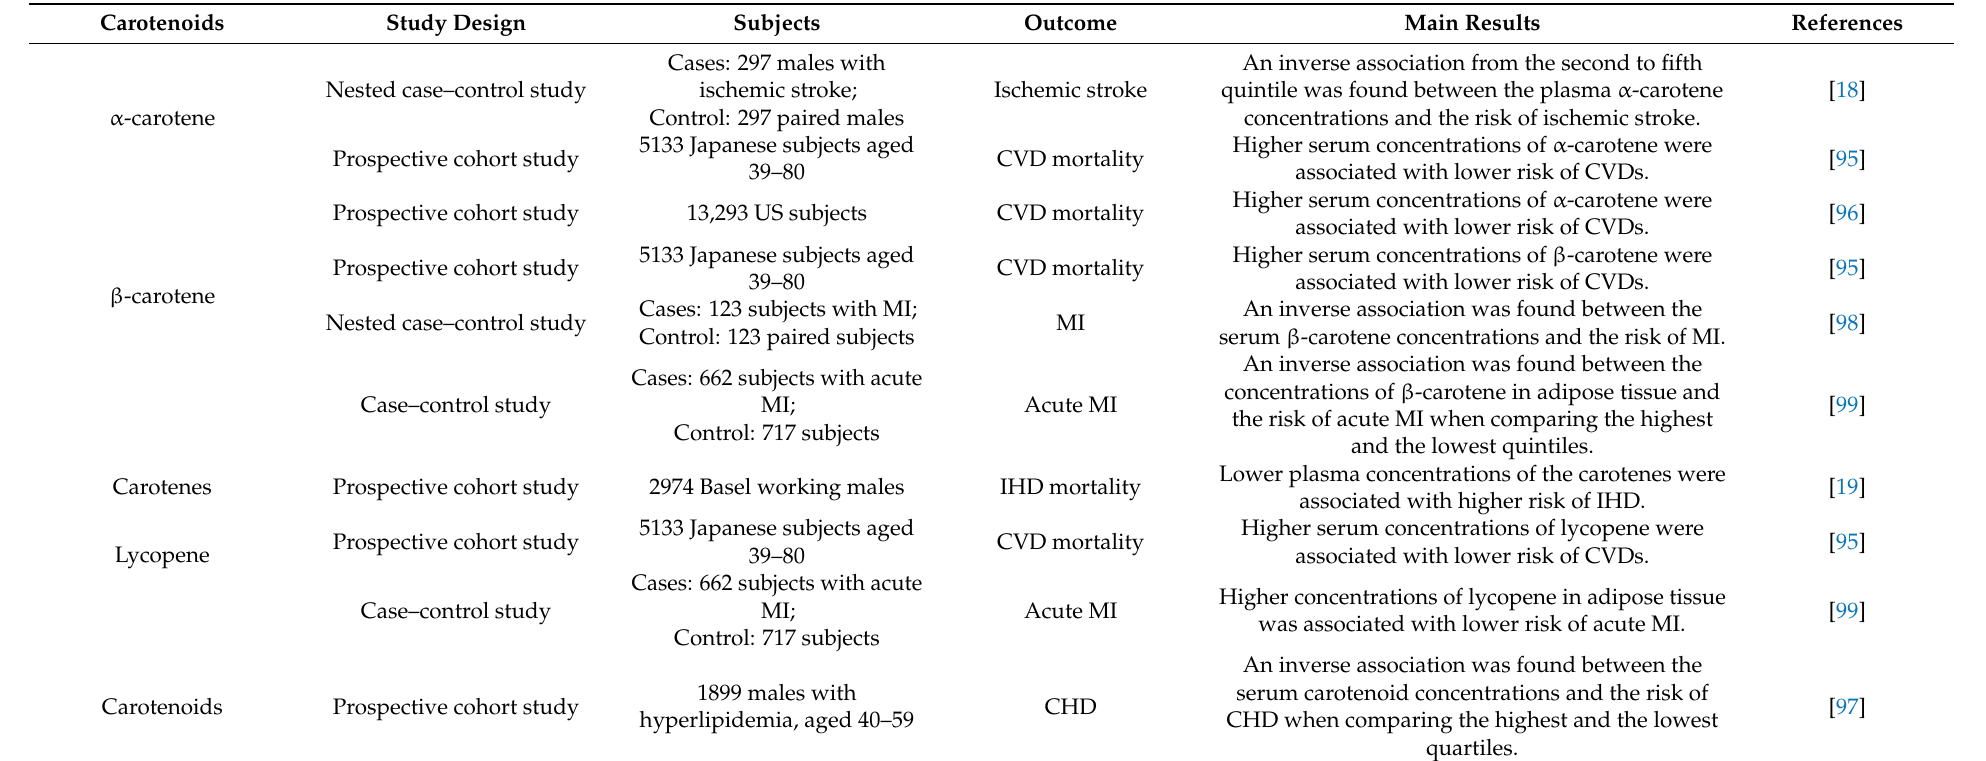
Table 3. Inverse associations between the circulating or adipose carotenoids and the risk of